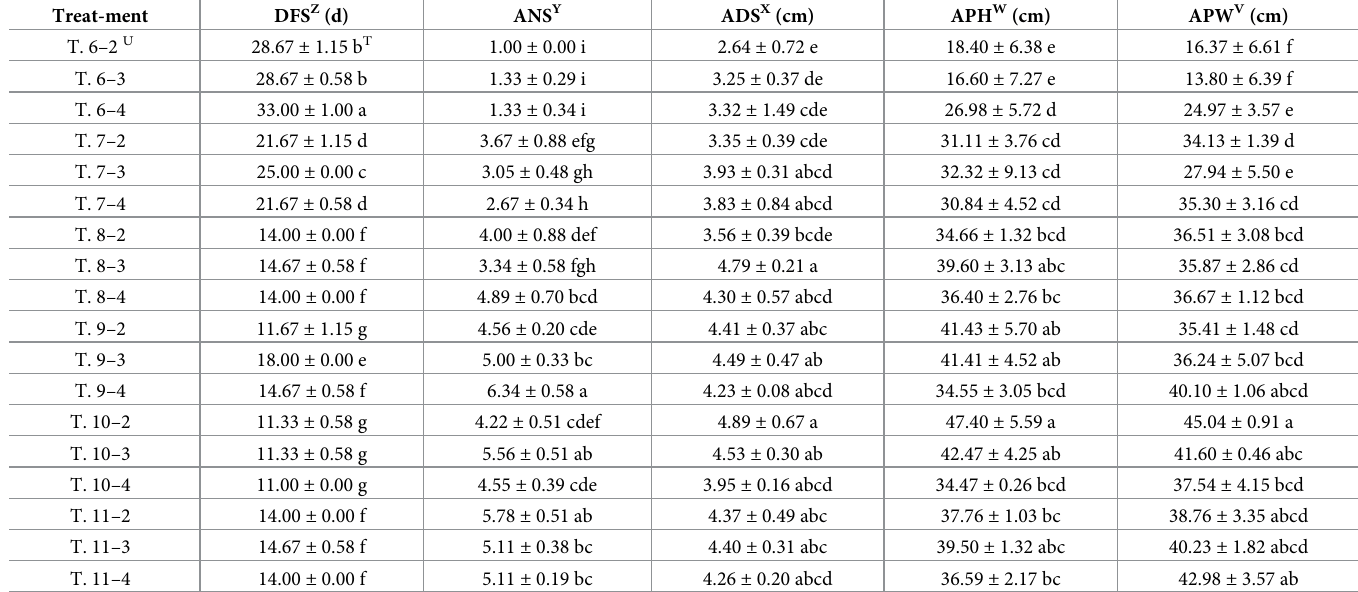
Table 9. Bud break and plant growth of ‘Hang Baishao’ after transfer to a glasshouse with artificial chilling and HA treatments.